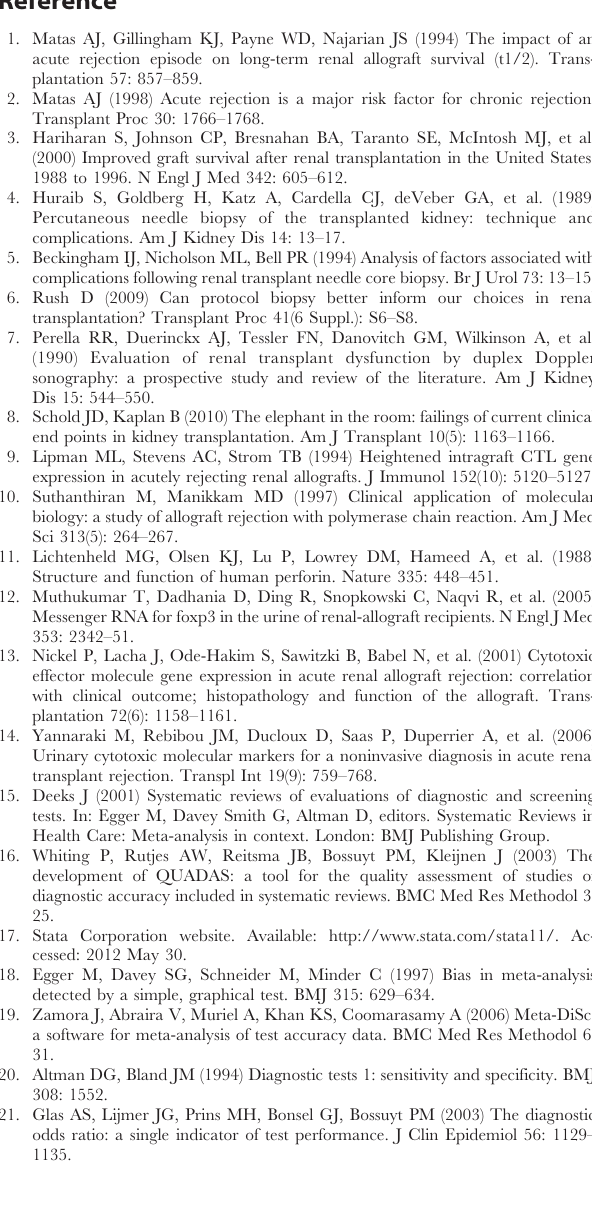
Table S2 Quality assessment of the included articles. Abbreviation: QUADAS, Quality Assessment of Diagnostic Accuracy